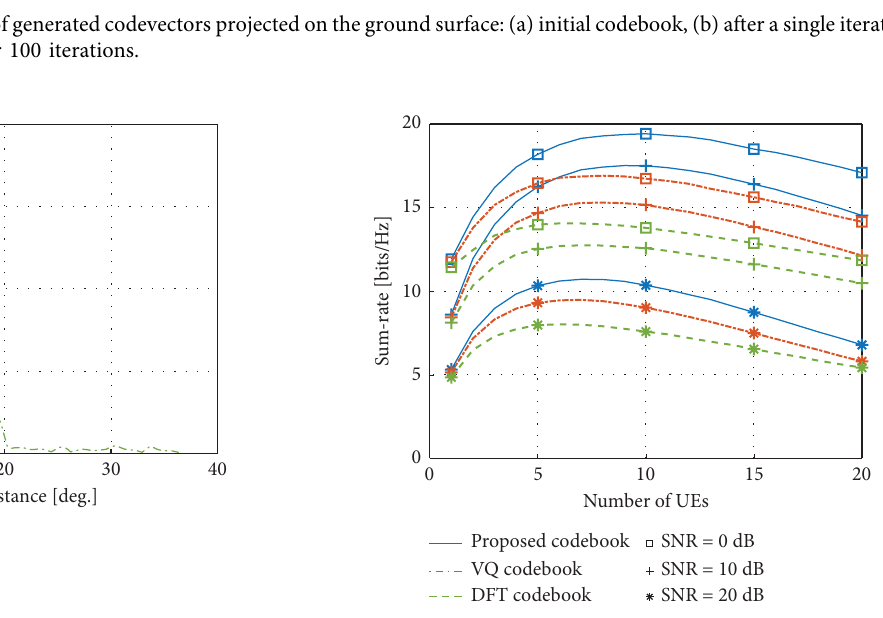
Figure 9: Probability density functions for the angular distance. Figure 10: Sum-rate versus the transmission rank using ZF beamforming at diferent channel